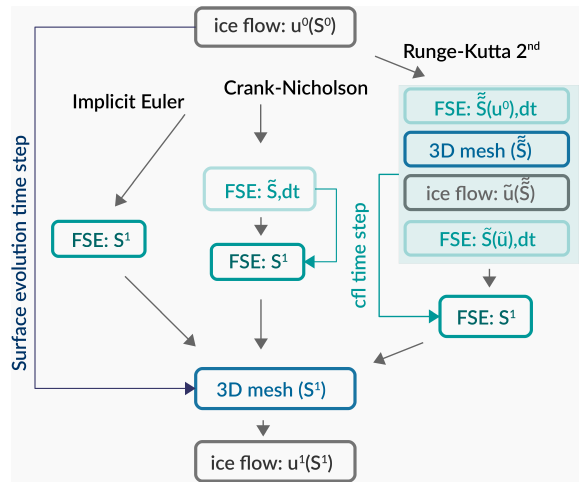
Figure 1. Model chain free-surface evolution schematically drawn for the three different time discretisation schemes: implicit Euler, Crank–Nicholson and Runge–Kutta. Ice flow represents the ice ve- locity computations, and FSE represents the free-surface evolution. S 0 denotes the surface elevation at the previous time step, and u 0 denotes the corresponding velocity field, whereas S 1 is the resulting surface